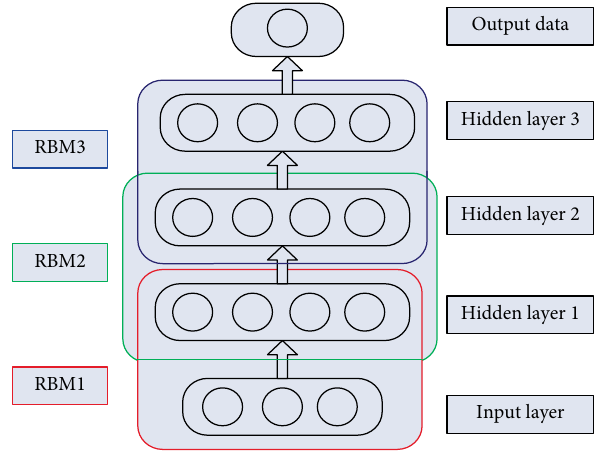
Figure 5: Structure of the deep confidence network based on the Boltzmann